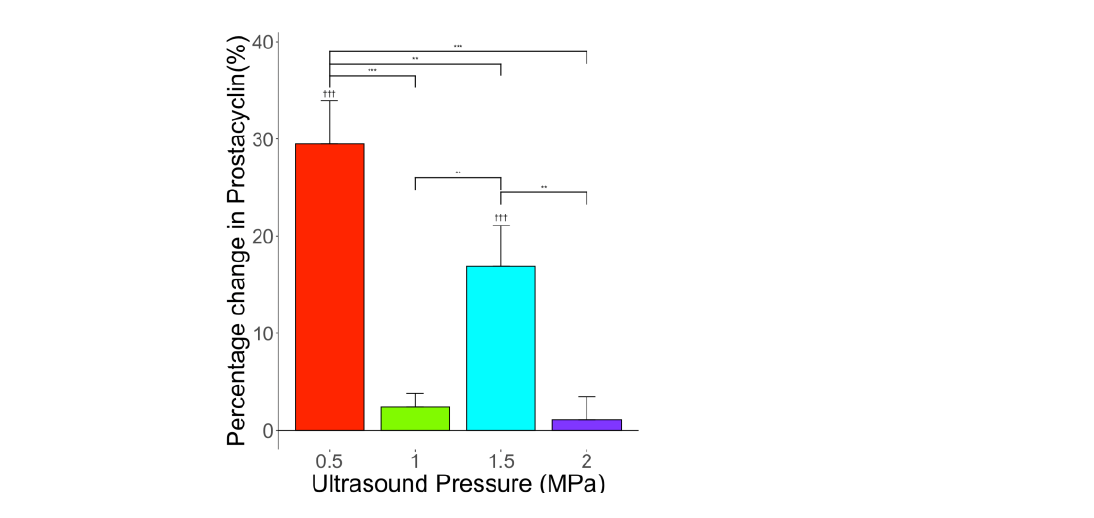
Figure 8. Effect of US on PGI 2 levels for various levels of ultrasound peak negative pressures — 0.5, 1, 1.5, and 2 MPa — showing significant change in PGI 2 levels compared to control. n = 6 for each group. “**” indicates statistical significance between treatment groups with p < 0.01. “***” indicates statistical significance between groups with p < 0.001. “†††” indicates statistical significance between control and treatment group p < 0.001.